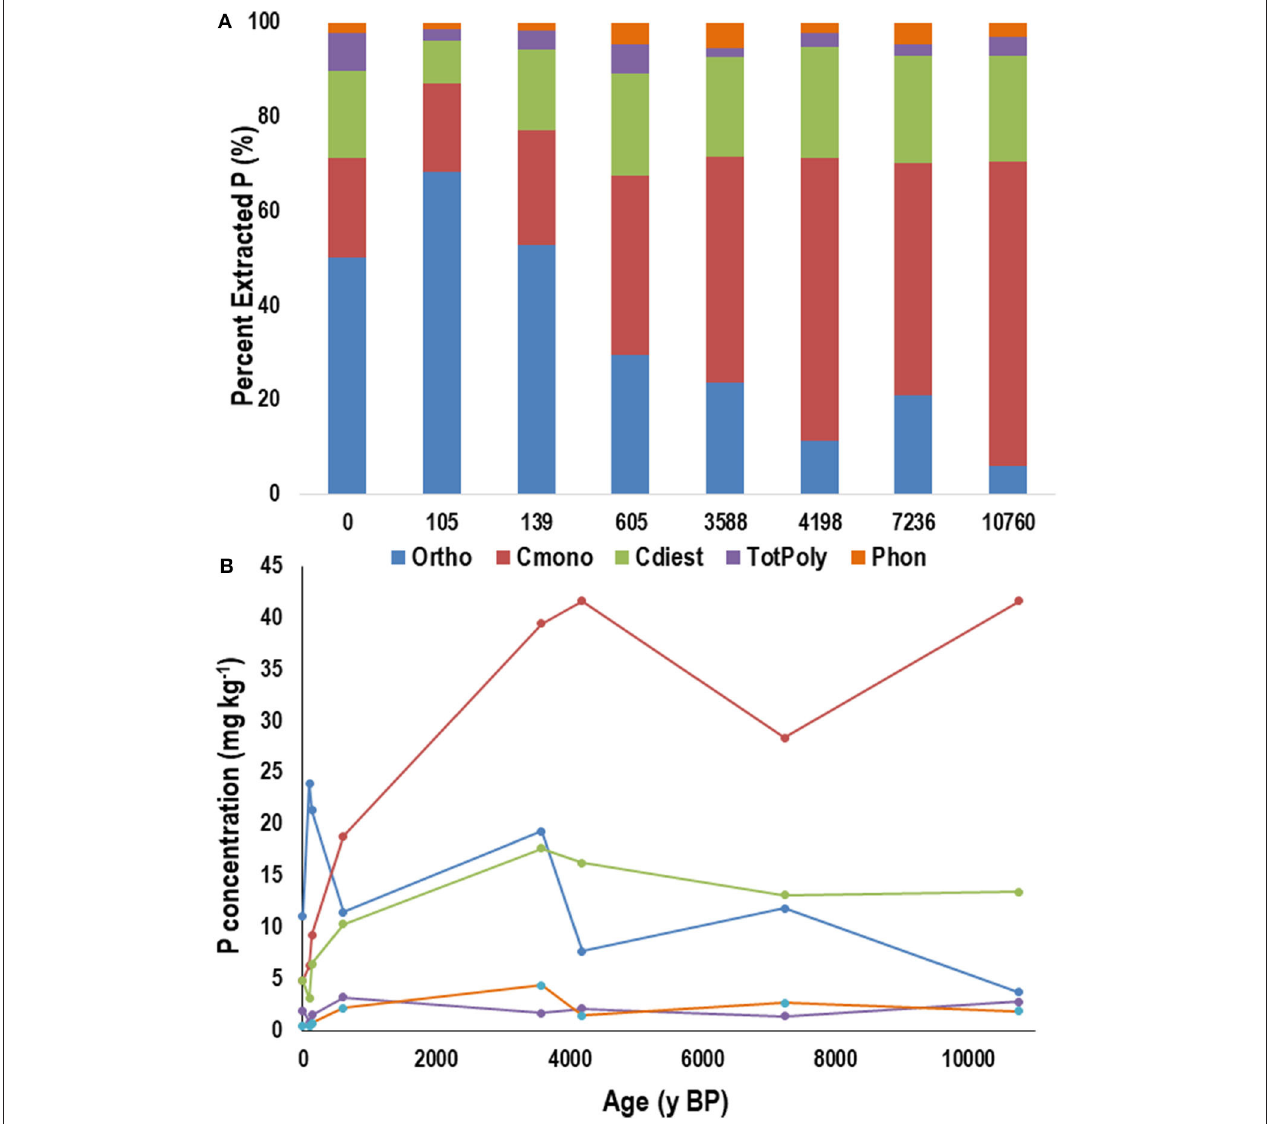
FIGURE 8 | Average proportion (A) and concentration (B) of phosphorus (P) in NaOH-EDTA extracts analyzed by P-NMR for the main groupings of P compounds in the mineral (A or B, depending on age) horizon from the Calvert Island chronosequence. Ortho, orthophosphate; Cmono, Cdi, orthophosphate monoesters and corrected for degradation during analysis; totPoly, total polyphosphates; Phon, phosphonates. Values are means; n =